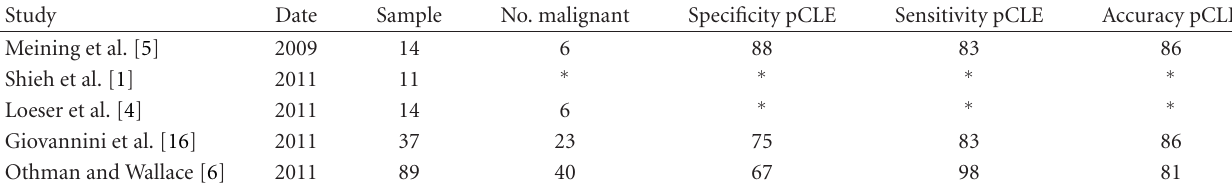
Table 1: Summary of study results.